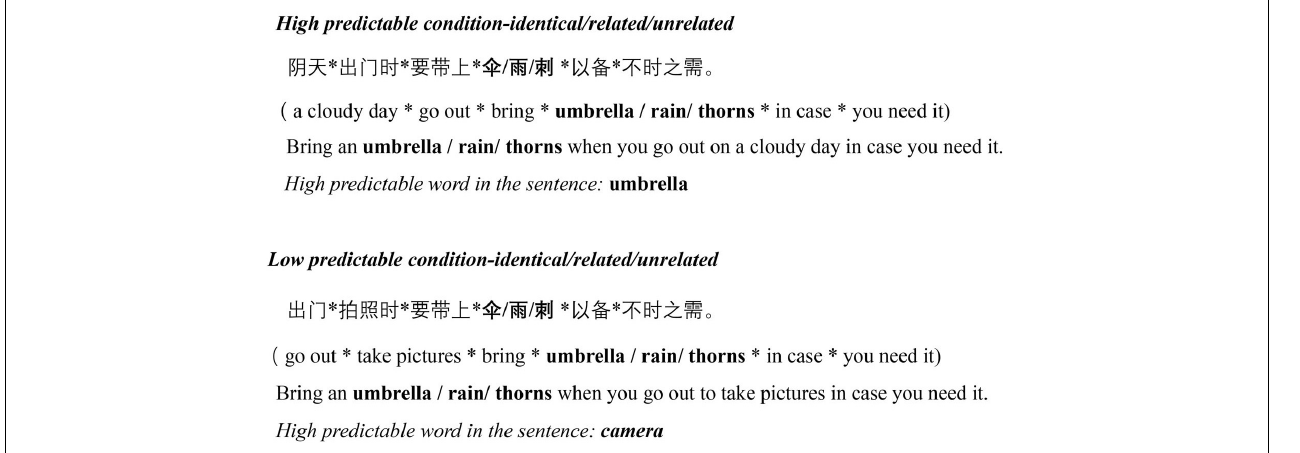
FIGURE 1 | Example of experimental material. In the example, “umbrella” was the target word setting in the experiment, and it was also a preview word under the identical preview condition. The word “rain” was a semantical preview word, which has a sematic association with the target word “umbrella.” The word “thorns” was an unrelated preview word, and there was no relationship between “thorns” and the target word “ umbrella.” The target and preview words were embedded in the two kinds of high-constraint sentences with the target word either high-predictable (“Bring an umbrella when you go out on a cloudy day ...... ”) or low-predictable (“Bring an umbrella when you go out to take pictures ...... .” Note that this is still a high-constraint sentence with the high-predictable word “camera”) in the sentence. In the experiment, when the readers’ fixation located before the boundary, one of the three kinds of preview words “umbrella” or “rain” or “thorns” was presented in the target position. When the reader’s fixation across the boundary, the preview word in the target position immediately turns to the target word “umbrella.”